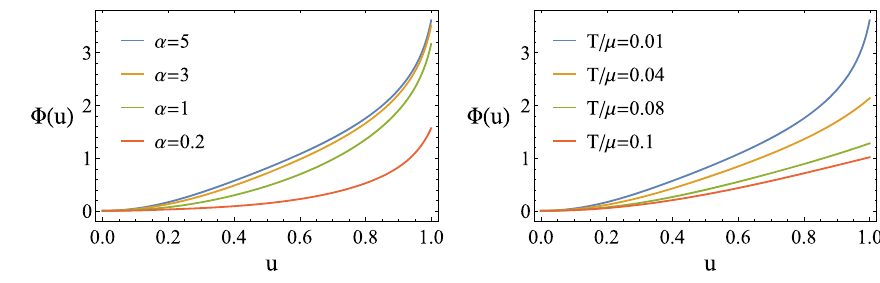
Fig. 1 Plots of (cid:3)( u ) as the function of u for different α and different T . Left plot is for T = 0 . 01 and right plot is for α =